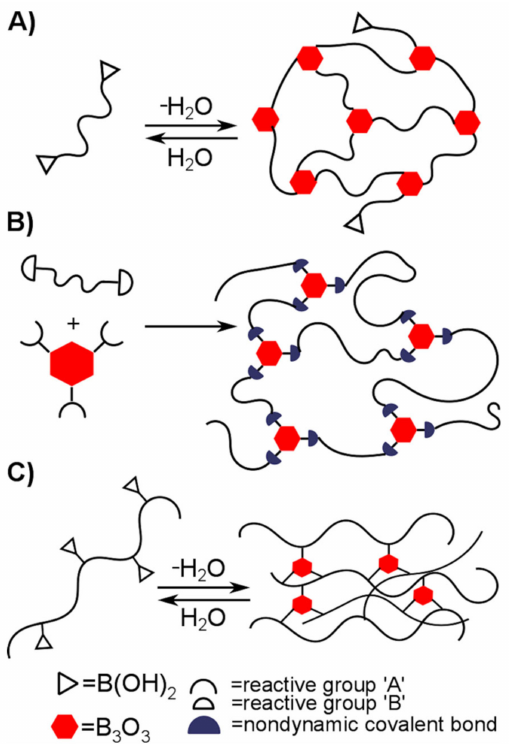
Figure 7. Synthetic strategies for the synthesis of boroxine-based vitrimers: ( A ) condensation of telechelic boronic diacids, ( B ) reaction between boroxines equpped with functional groups and other molecules containing complementary reactive groups, ( C ) condensation of macromolecules with boronic aicd side